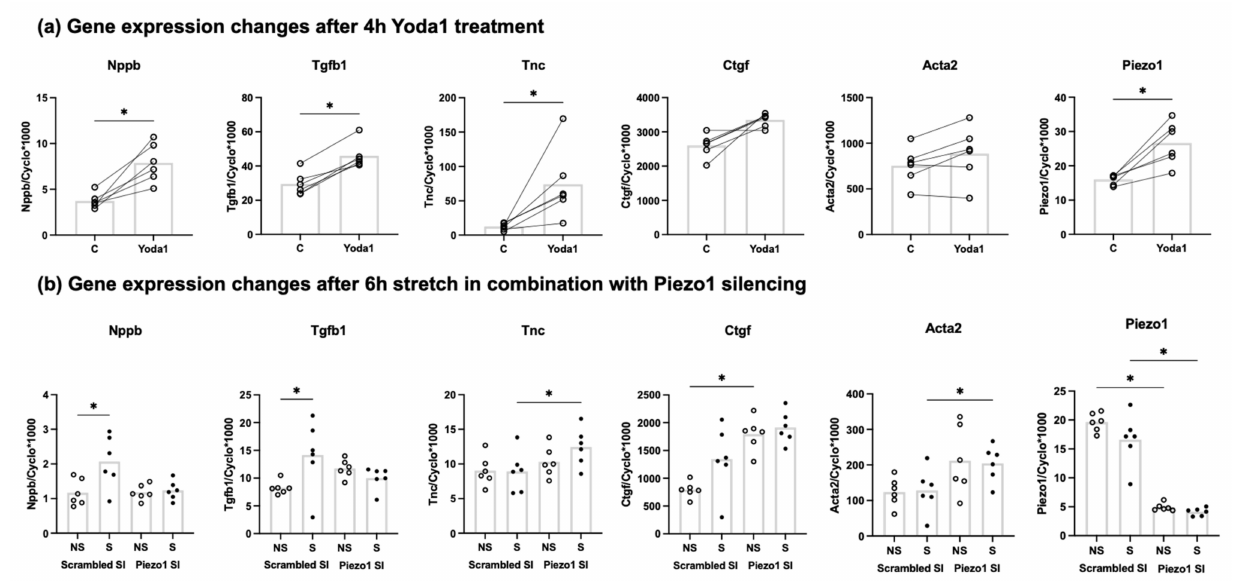
Figure 4. Relative mRNA expression levels of Nppb, Tgfb1, Tnc, Ctgf, Acta2, and Piezo1 in cardiac fibroblasts after stimulation with Piezo1 agonist Yoda1 after 4 h ( n = 6) ( a ) Relative mRNA expression of Nppb, Tgfb1, Tnc, Ctgf, Acta2, and Piezo1 in cardiac fibroblasts exposed to 10% 1 Hz cyclic stretch for 6 h (S) or non-stretched (NS) conditions after transfection with either control siRNA (Scrambled SI) or Piezo1-specific siRNA (Piezo1 SI) ( n = 6) ( b ) * p < 0.05. Bar indicates